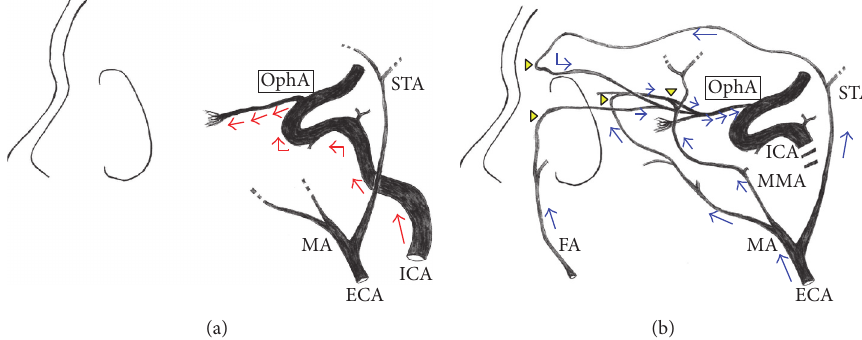
Figure 2: (a) Usually, the ophthalmic artery receives blood flow from the internal carotid artery, which means that the ophthalmic artery is visualized antegradely from the bifurcation from the internal carotid artery (red arrows). (b) However, when advanced stenotic lesions are seen in the internal carotid artery, the ophthalmic artery instead receives blood flow from the external carotid artery; thus, it is visualized retrogradely from the peripheral side via the multiple anastomoses (arrow heads) with the external carotid artery (blue arrows). ∗ OphA, ophthalmic artery; ICA, internal carotid artery; ECA, external carotid artery; STA, superficial temporal artery; MA, maxillary artery; FA, facial artery; MMA, middle meningeal artery.